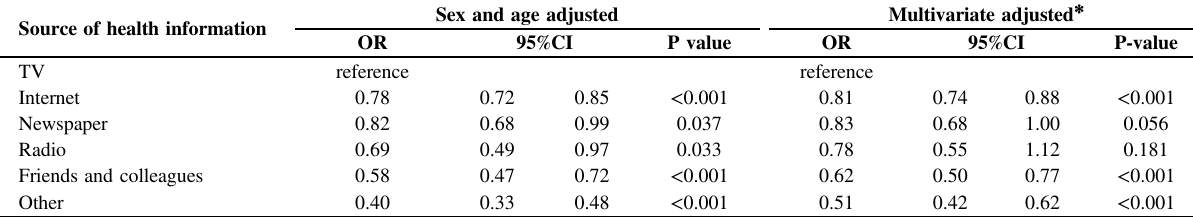
Table 2 Association between source of health information and willingness to receive the COVID-19 vaccine Source of health